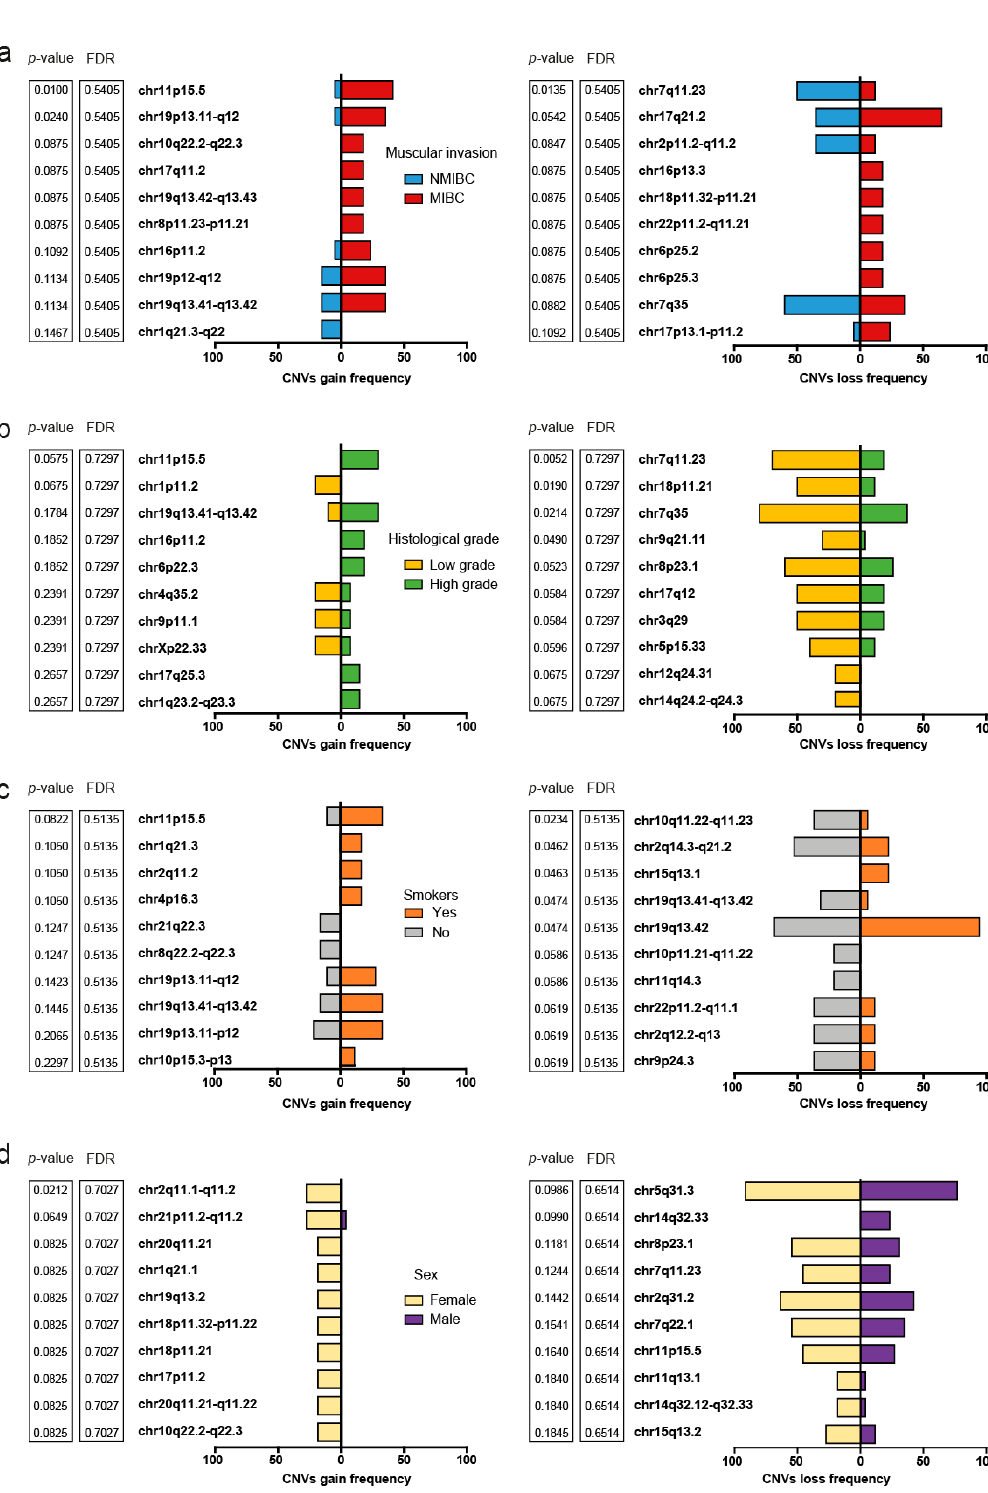
Figure 6. Muscle invasion, histologic grade, smoking, gender, and frequency of cytobands affected by CNV. The 10 most affected cytobands are ordered in ascending order from the smallest p -value according to Fisher’s exact test on top: ( a ) Comparison of the frequency of gains and losses in copy number according to the muscle invasion phenotype; ( b ) Comparison of the frequency of copy number gains and losses according to histological grade; ( c ) Comparison of the frequency of copy number gains and losses according to smoking; ( d ) Comparison of the frequency of gains and losses in the number of copies according to the sex of the patients.